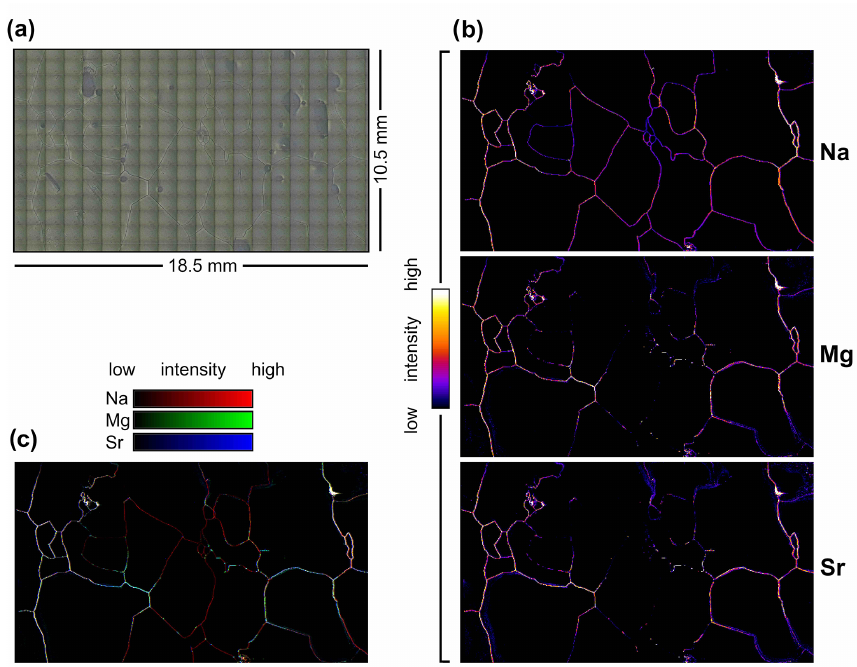
Figure 4. EPICA Dome C 3092 sample from MIS 5.5. Panel (a) shows an optical image; panel (b) elemental maps of Na, Mg and Sr, respectively, in the same area; (c) composite RGB map of the three elements. The main core axis runs from left (top) to right.